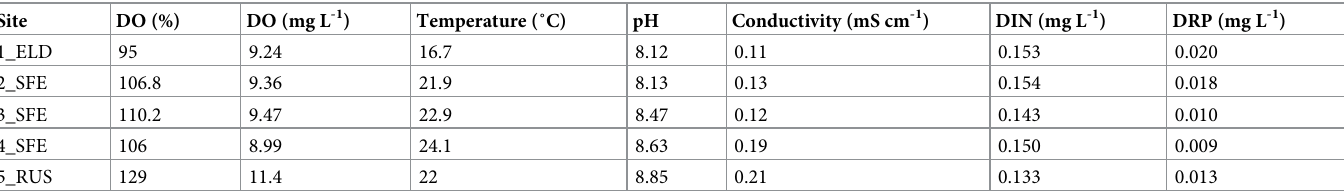
Table 1. Physicochemical parameters collected at each sampling site.